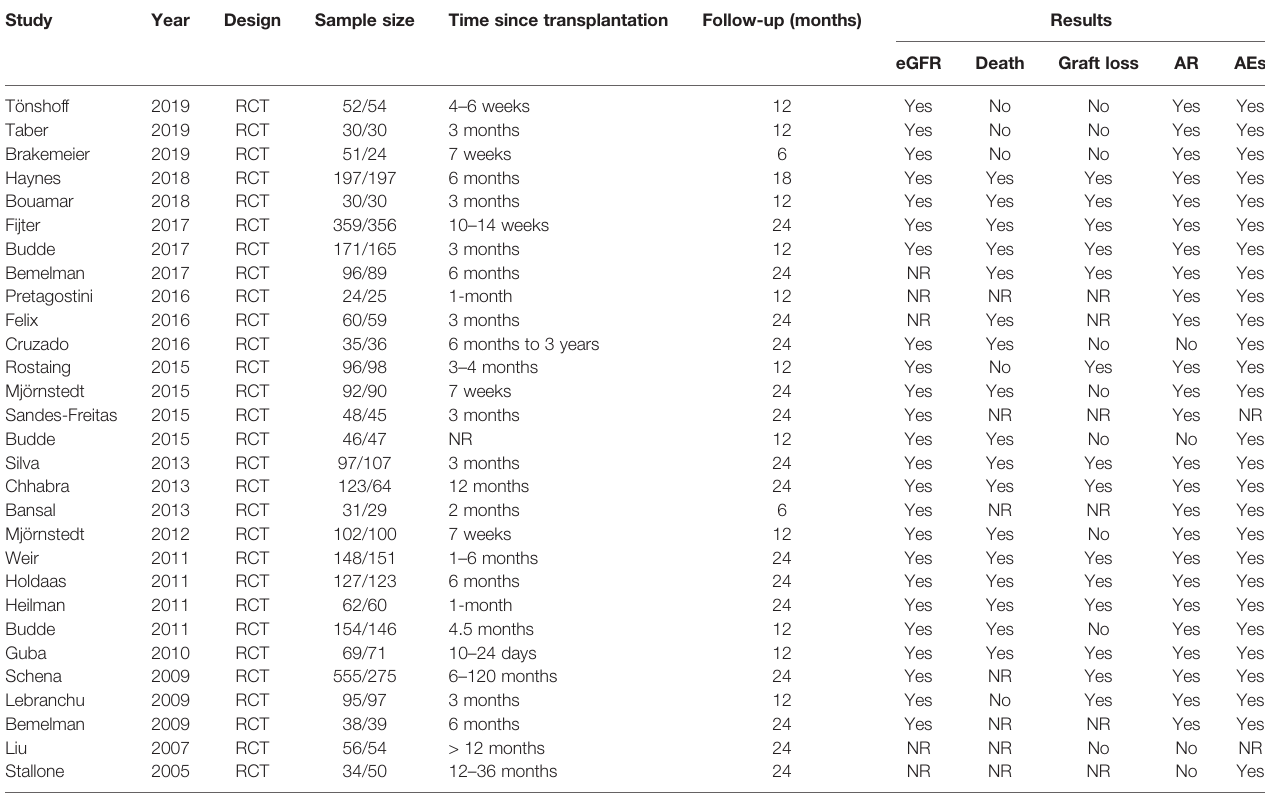
TABLE 1 | Baseline overview of 29 included